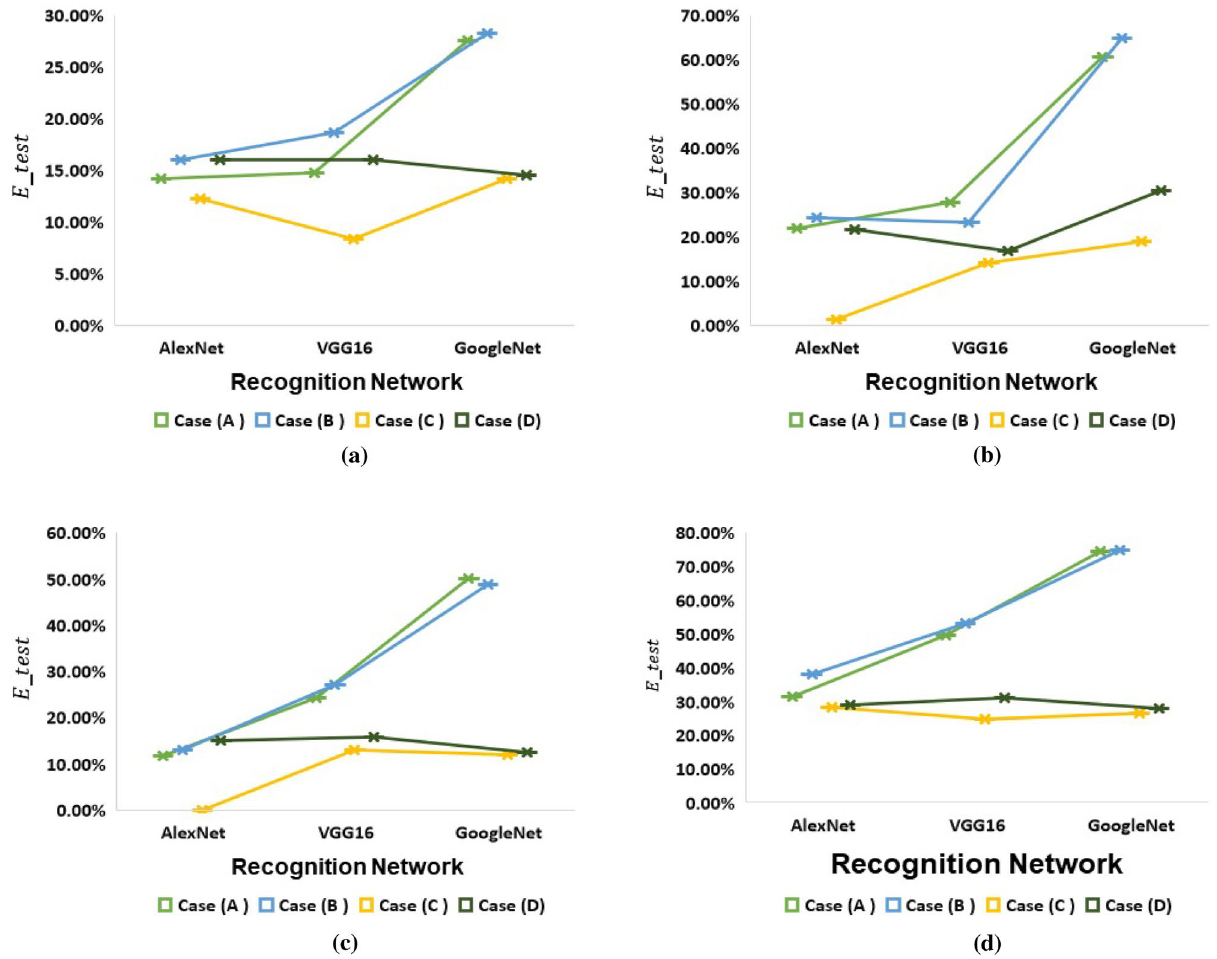
Figure 11. Visualization for the E test recorded by each model under the different training cases for ( a ) Latin dataset, ( b ) Malay dataset, ( c ) Korean dataset, and ( d ) Sanskrit(Indo-Aryan)